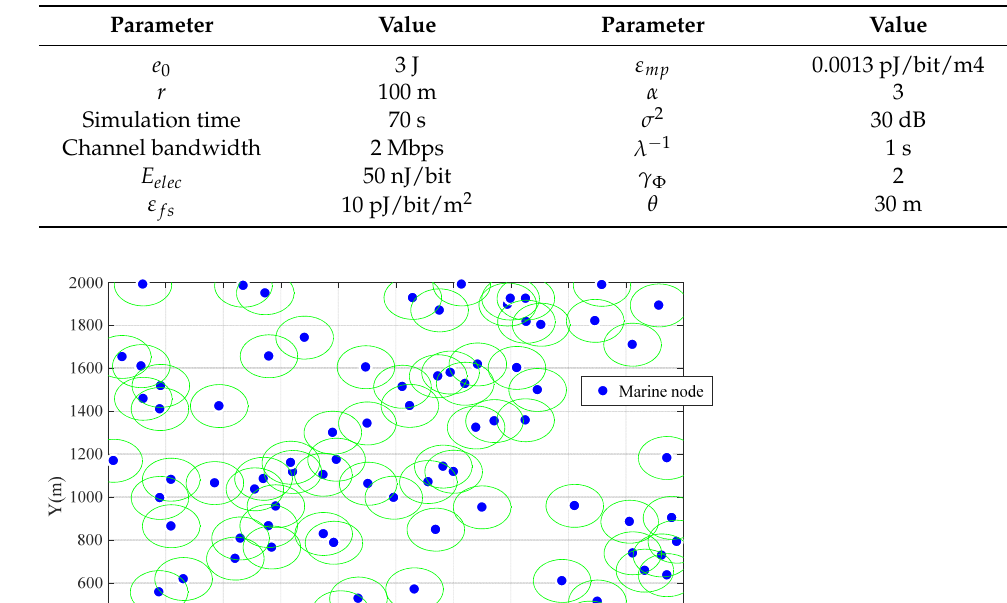
Table 2. Simulation parameters.